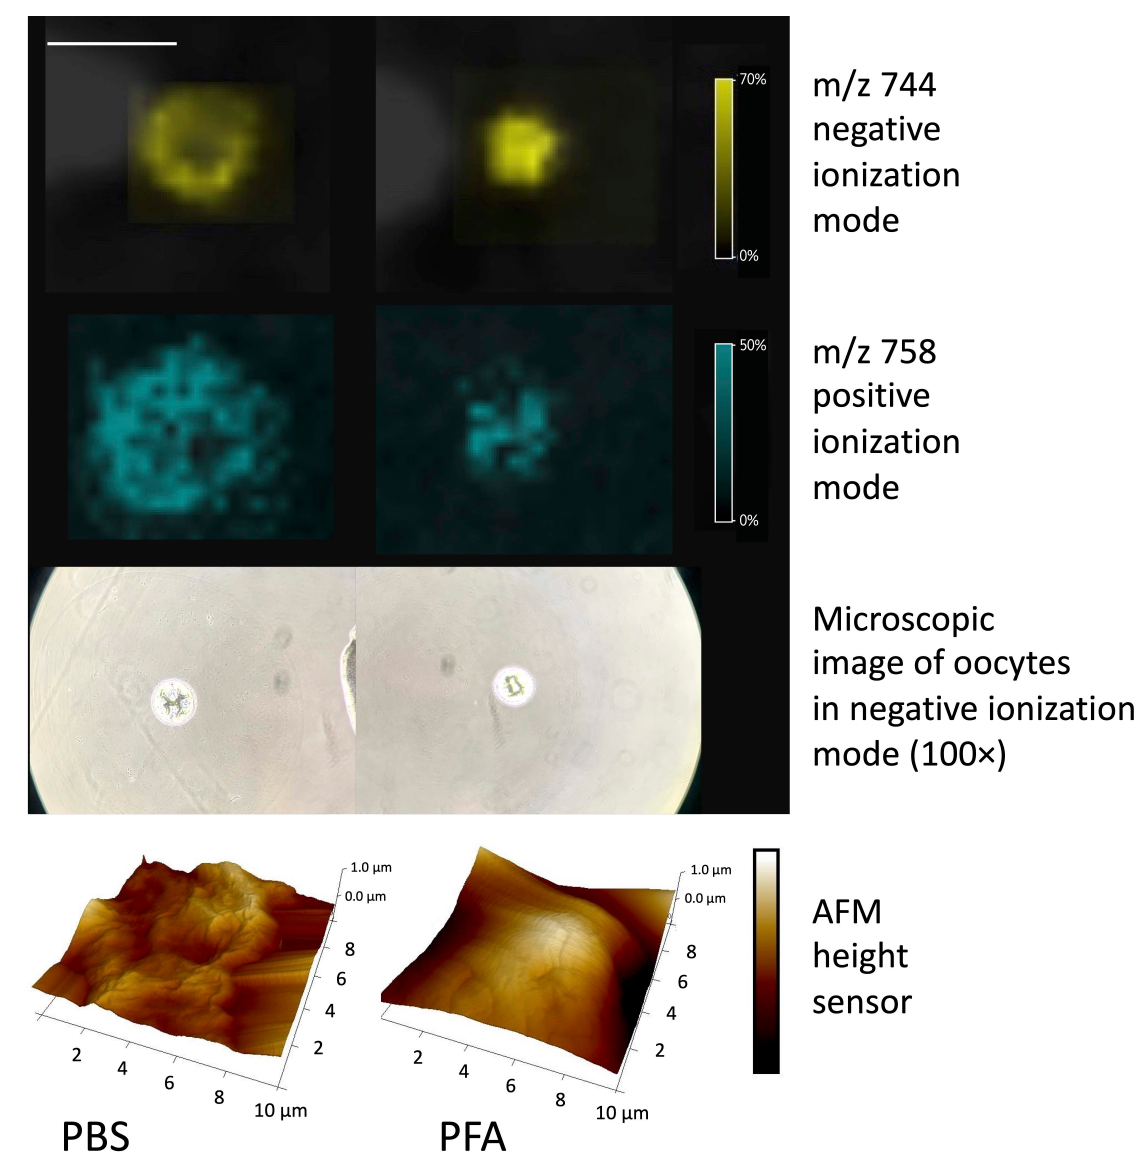
Figure 13. Oocyte washed with PBS ( left ) and the oocyte fixed with 4% PFA ( right ), negative and positive ion mode, with microscopic images of oocytes in the negative ionization mode. Additionally, AFM (Atomic Force Microscope) measurement of both types of the sample, to check of the morphology differences between cells, also visible by the MALDI-IMS. Size bar for images: 500 µ